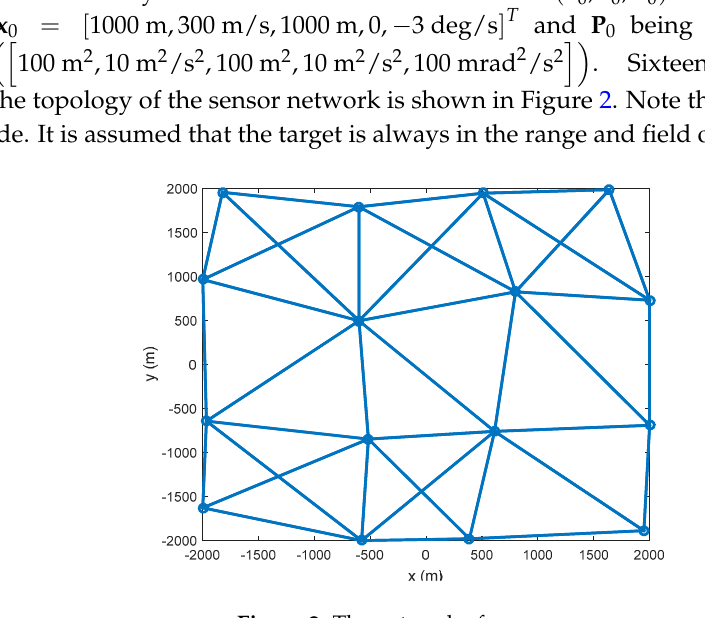
Figure 2 . The network of sensors. Figure 2. The network of sensors.